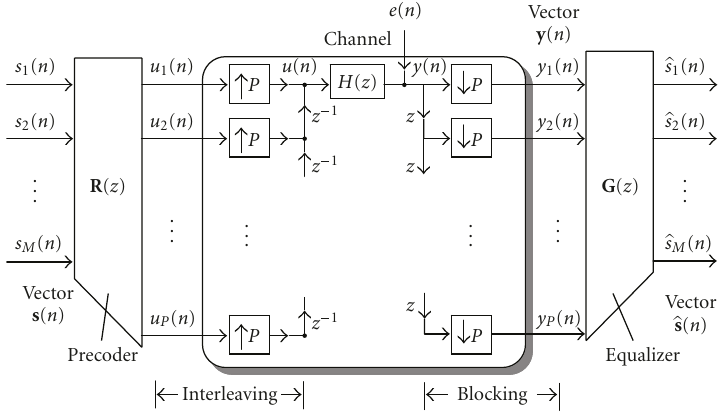
Figure 1: Communication system with redundant filter bank